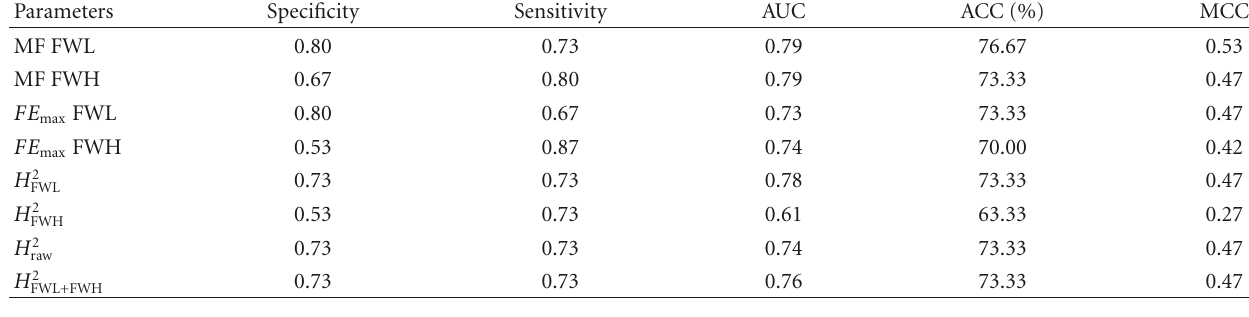
Table 6: Comparison of ROC curve characteristics for labor prediction obtained with frequency (MF and FE max ) and synchronization ( H 2 ) parameters. AUC, ACC and MCC stand for Area Under the Curve, ACCuracy and Mathews Correlation Coe ffi cient, respectively.